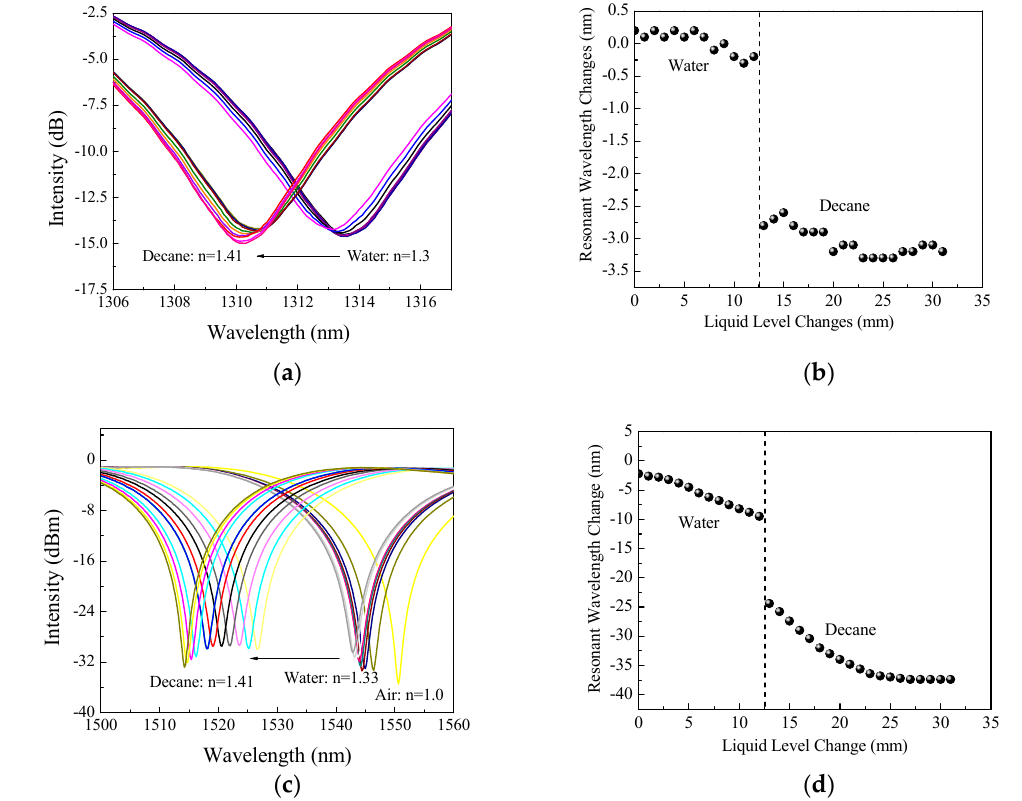
Figure 11. ( a ) Spectrum changes of LP 06 ; ( b ) Resonant wavelength changes of the LP 06 ; ( c ) Spectrum changes of LP 08 ; ( d ) Resonant wavelength changes of the LP 08 with layered liquid interface and level changes (water and decane).